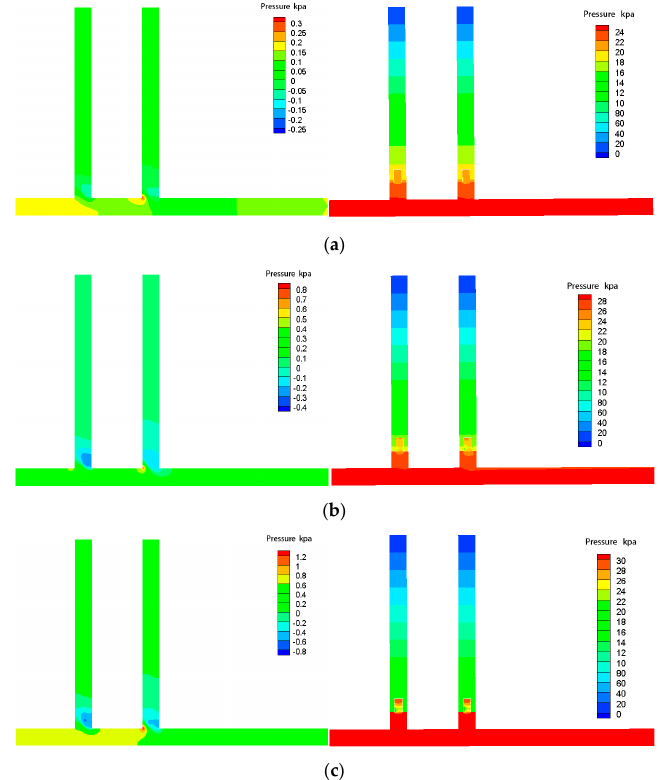
Figure 7. The pressure distribution of the branch vs. the different inlet flow rates at a temperature of 23 °C. ( a ) Pressure distribution at the inlet flow at a rate of 60 t/h (left is no rectifier nozzle); ( b ) pressure distribution at the inlet flow at a rate of 120 t/h (left is no rectifier nozzle); ( c ) pressure distribution at the inlet flow at a rate of 140 t/h (left is no rectifier nozzle).